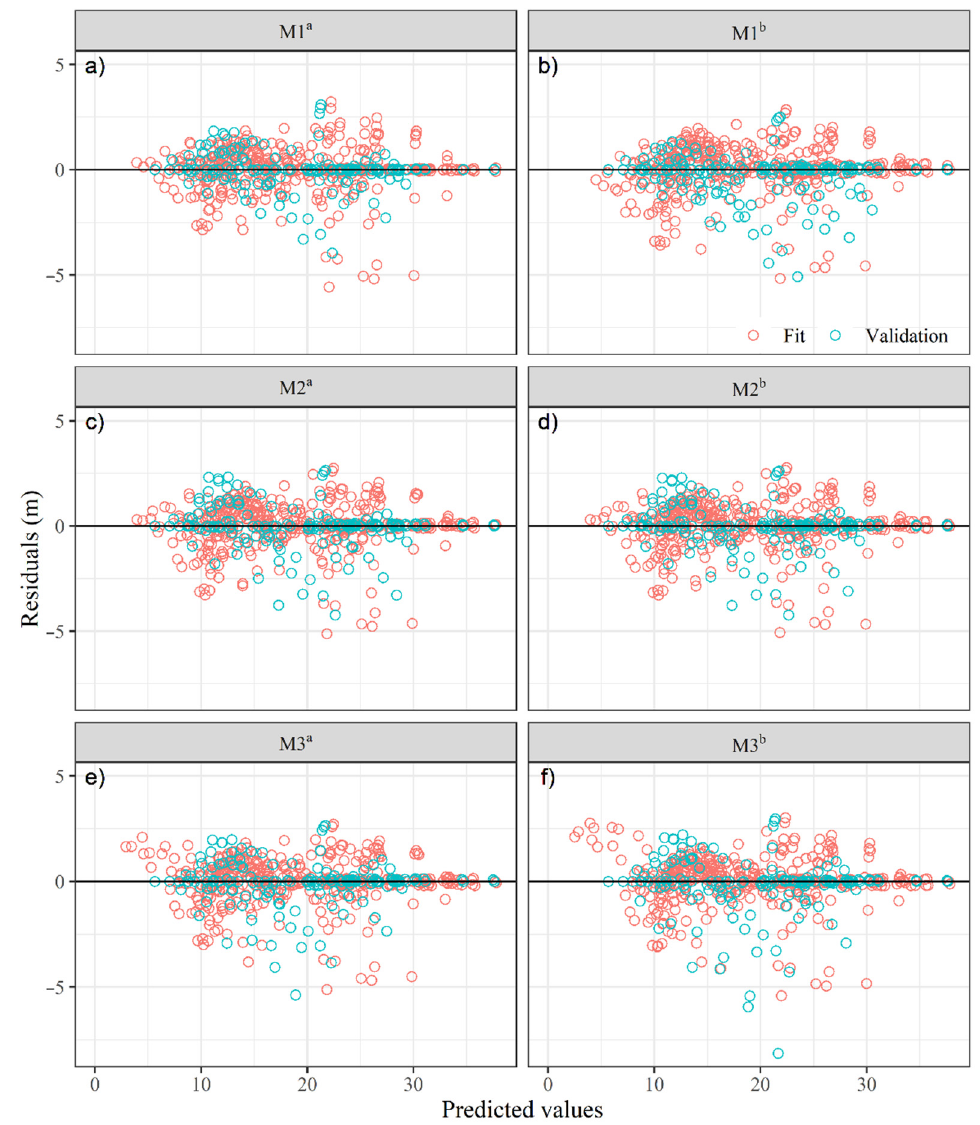
Figure 3. Residuals of the fitted dominant-height dynamic equations for patula pine. M1: Chapman- Richards ( a , b ), M2: Hossfeld IV ( c , d ), M3: Korf ( e , f ). a Fitting without the addition of site topographic and climatic variables; b fitting with the addition of site topographic and climatic variables.